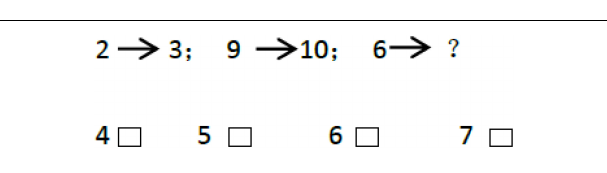
FIGURE 2 | Digital analogical reasoning test.